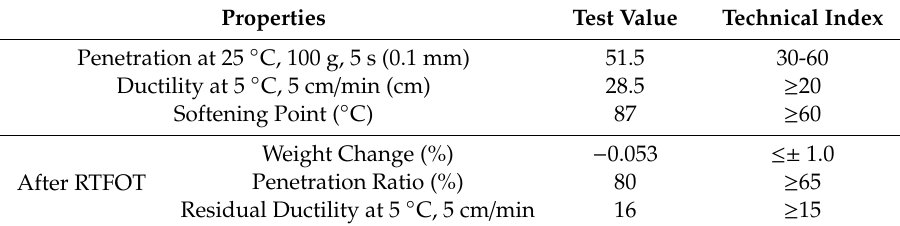
Table 1. Technical indexes of (Styrene-Butadiene-Styrene) SBS modified asphalt binder.